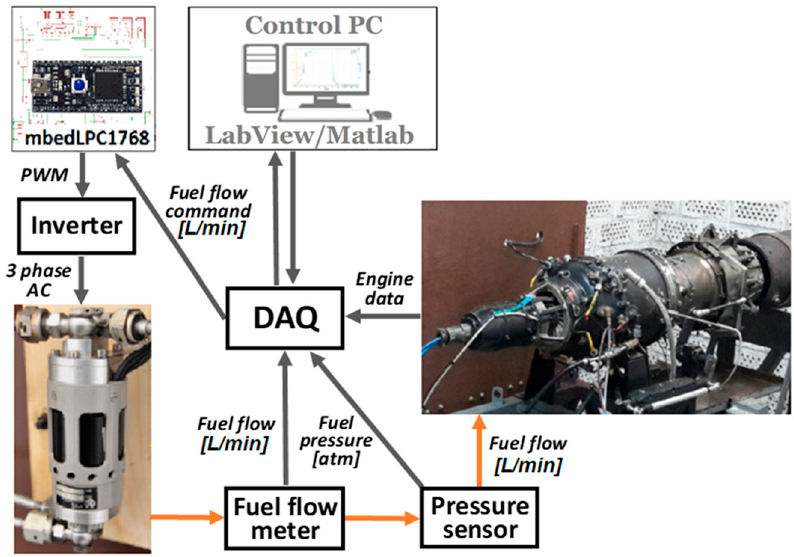
Figure 1. Block diagram of iSTC ‐ 21v engine control.